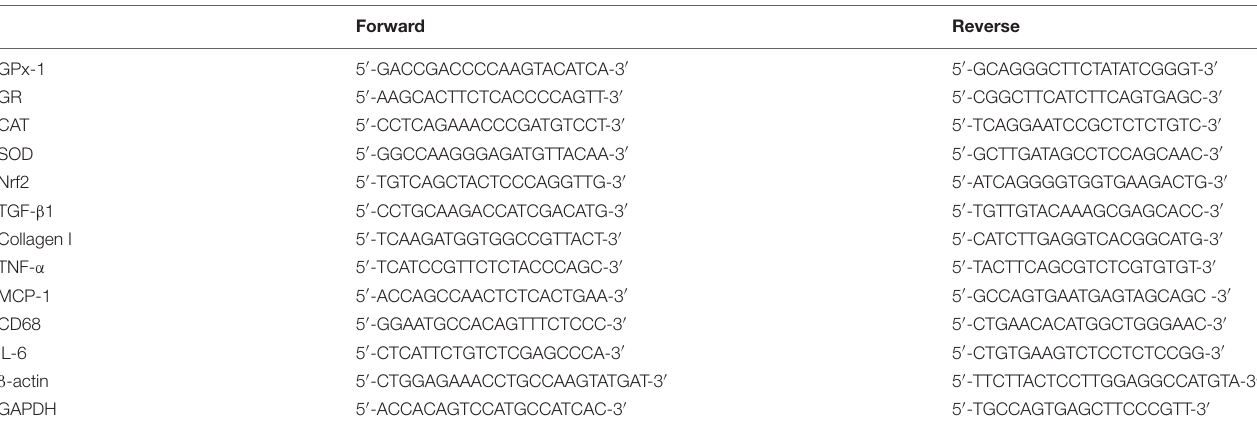
TABLE 1 | Sequences of primers used for real-time